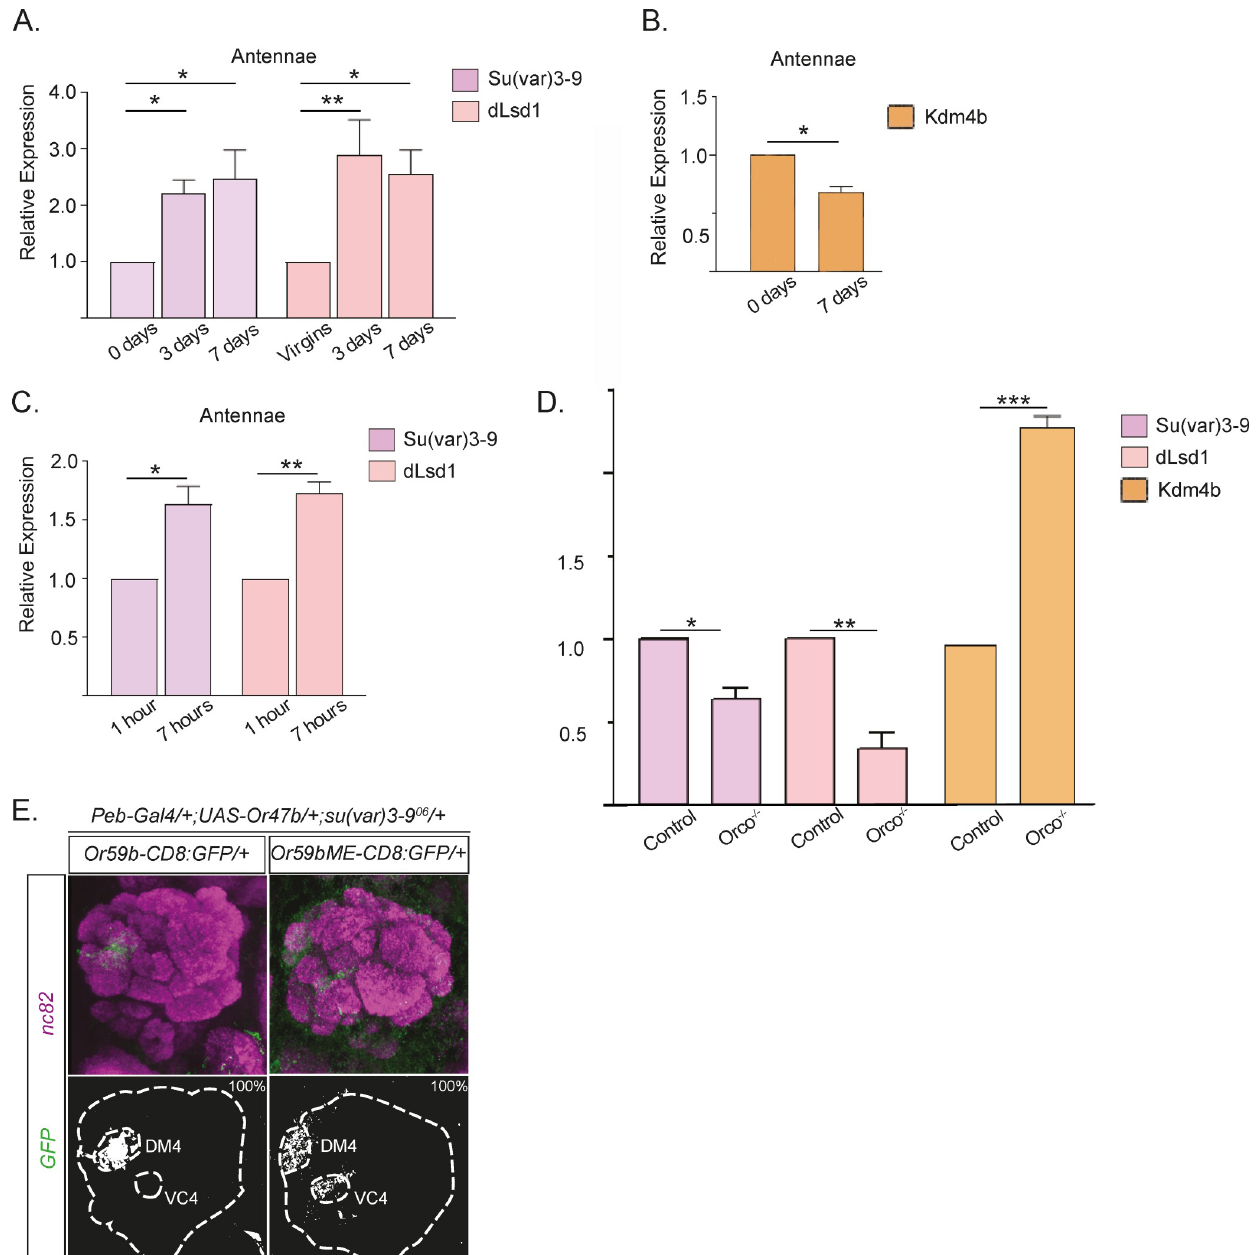
Fig 6. Dynamic expression of chromatin modulators regulates odorant receptor expression. (A) The graph shows Su(var)3-9 and dLsd1 mRNA levels in antenna at 1, 3, and 7 DPE ( � p < 0.05; �� p < 0.01; ��� p < 0.001; error bars represent SEM (S2 Data). (B) The graph shows the Kdm4b mRNA levels in the antenna at 1 and 7days post-eclosion (DPE). Note that Su(var)3-9 / dLsd1 shows contrasting regulation to Kdm4b after eclosion. (C) This graph shows the mRNA levels of Su(var)3-9 and dLsd1 in the antenna at 1 hour and 7 hours after eclosion. Note that the expression levels increase to almost double at 7 hours post-eclosion. (D) The graph compares control ( w 1118 ) and Orco mutant mRNA levels of Su(var)3-9 , dLsd1 , and Kdm4b in the antenna at 4 DPE. Note that the expression levels are lower for Su(var)3-9 and dLsd1 and higher for Kdm4b in Orco mutant flies. (E) GFP expression (green) driven by the Or59b reporter. Note that the loss of Or59b reporter expression in flies with Or47b ectopic expression is rescued in a Su(var)3−9 06 heterozygote background. Synaptic neuropil is labeled with the presynaptic marker nc82 (magenta). Control flies were crossed to w 1118 (S4 Data).